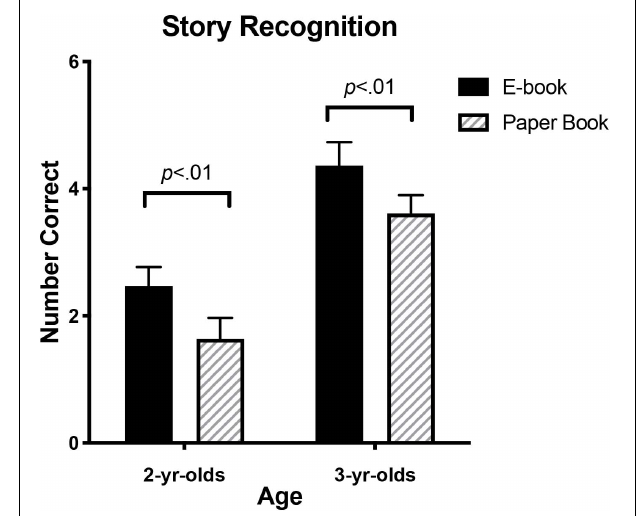
FIGURE 5 | Means and standard errors for children’s recognition memory scores by age and book